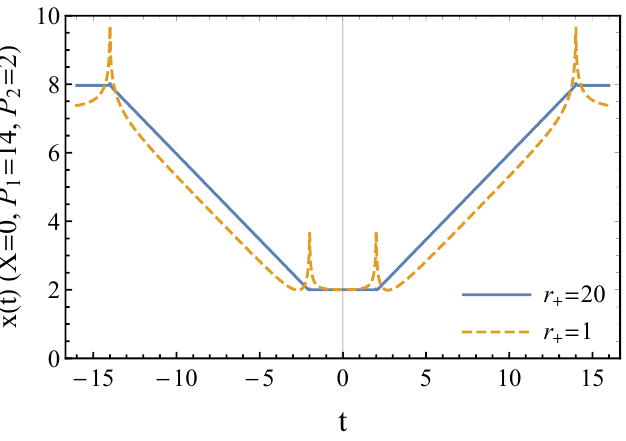
Figure 13 . Time dependence of trajectory of the minimal surface with X = 0 , P 1 = 14 , P 2 = 2 as a function of t . We plot how the x -coordinates of endpoint of the minimal area surface move under the time-evolution. The large r picture. In this setup, it starts at X = P